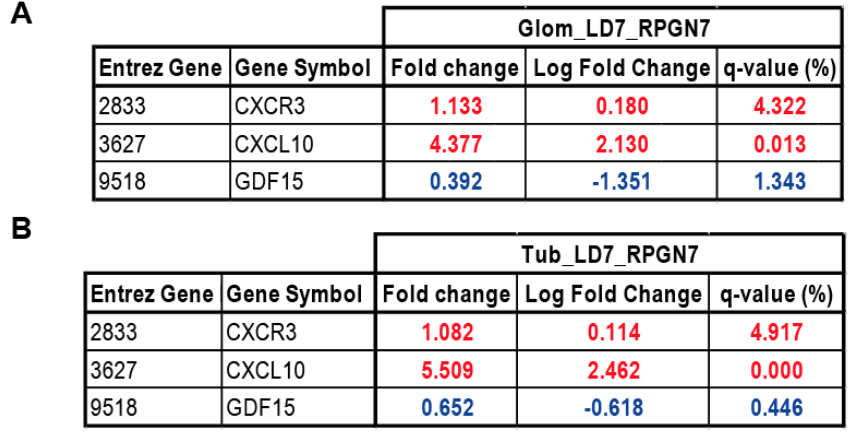
Figure 7. Gene expression analysis of GDF15, CXCL10 , and CXCR3 genes in ( A ) glomerular and ( B ) tubular compartment of manually microdissected kidney biopsies from patients with RPGN. Values